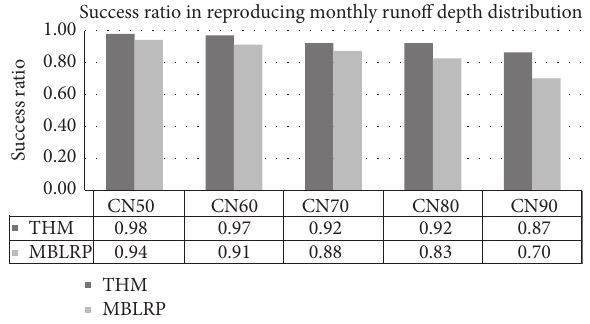
Figure 16: The proportions, among 104 gauges, that THM and the traditional approach succeeded in reproducing the distribution of the observed runoff depths of the hypothetical watershed with curve numbers of 50, 60, 70, 80, and